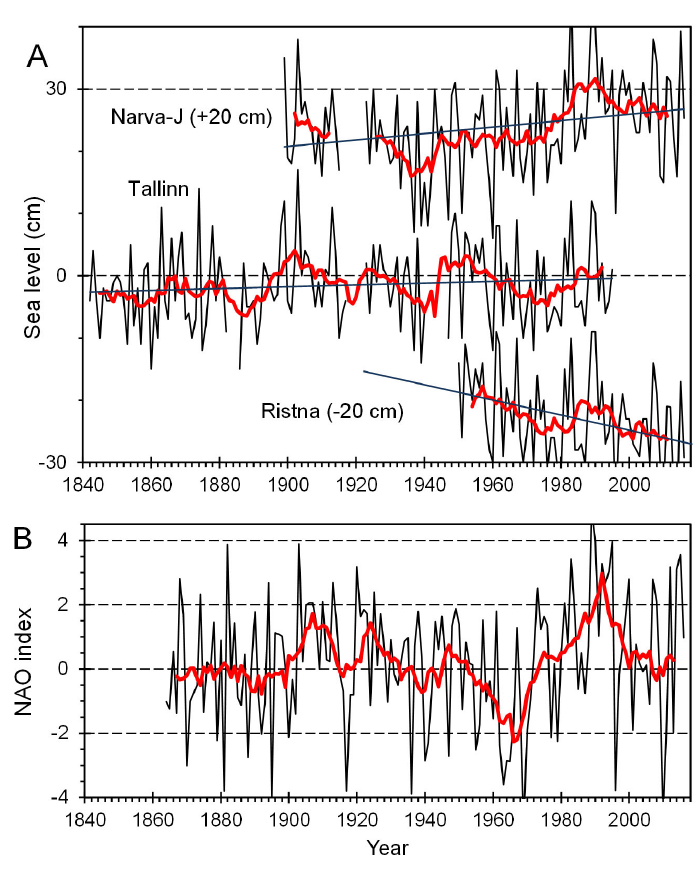
Fig. 6. Relative sea level variations at three tide gauges (Narva Jõesuu shifted for +20 cm and Ristna –20 cm) together with their 9-year moving averages, expressing a weak periodicity ( A ). Hurrel station-based (DJFM) NAO-indices with 9-year moving averages ( B ) (https: